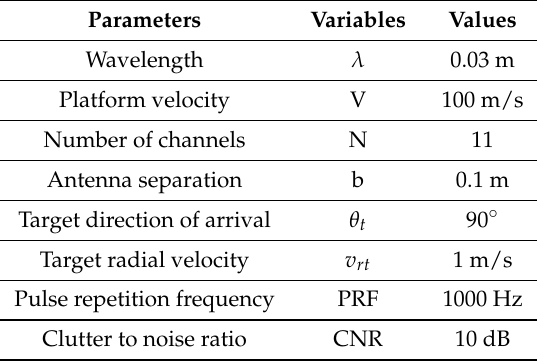
Table 1. Simulation